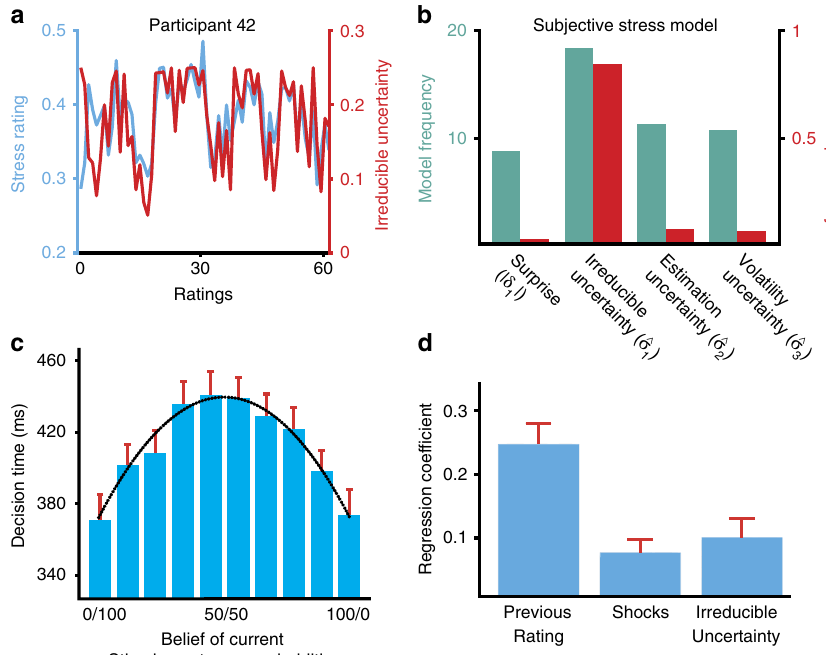
Figure 4 | Irreducible uncertainty predicts subjective stress. ( a ) Example subjective stress trajectory for one participant (blue) and irreducible uncertainty estimates for that individual (red). ( b ) Comparison of regression models of subjective stress. All models shared two components: the value of the previous rating and the number of shocks delivered since the last rating. The surprise model summed the surprise (| d 1 |) for each outcome since the previous rating, while models s 1–3 included the estimated uncertainty at each level of the Hierarchical Gaussian Filter at the time of rating. Irreducible uncertainty ( ^ s 1 ) provided the best fit to our participants ( n ¼ 45). ( c ) Irreducible uncertainty predicts prediction response times. A curve describing the variance of a Bernoulli distribution representing beliefs about probabilities, corresponding to irreducible uncertainty, predicts average response times (Pearson r ¼ 0.99, P o 0.001). ( d ) The winning regression model predicting subjective stress responses (mean r 2 ¼ 0.25). Shocks and irreducible uncertainty both predicted subjective stress ratings (single-sample t -tests, P o 0.001; P ¼ 0.0024). Error bars represent